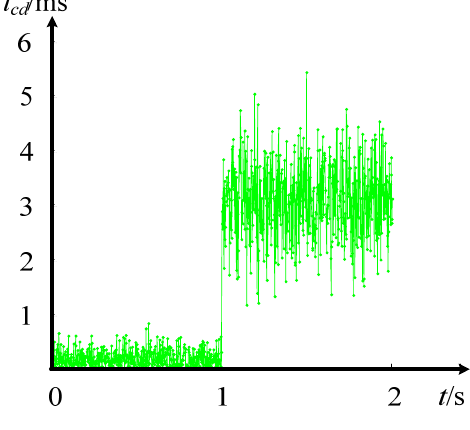
Figure 16. Inconsistent delay